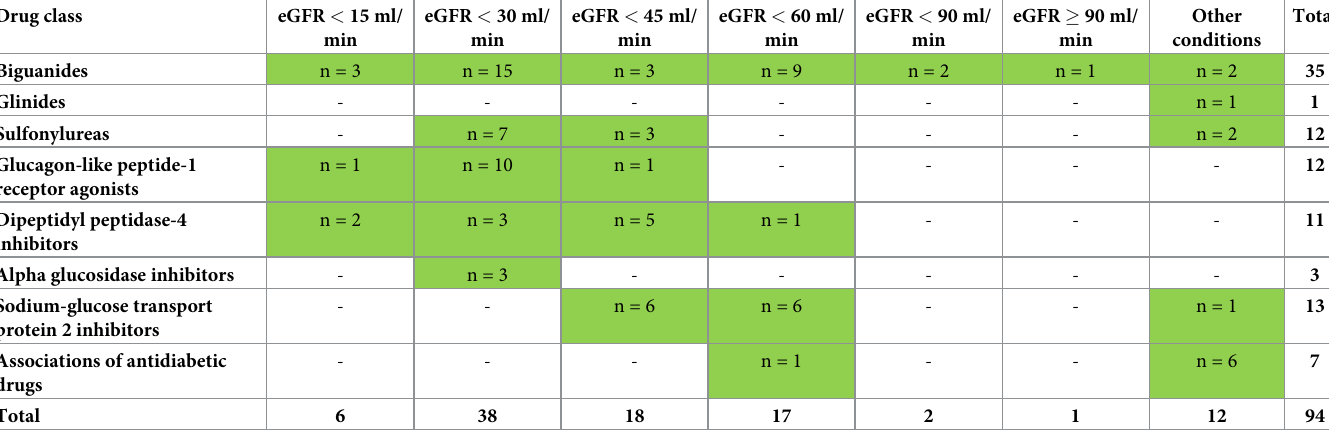
Table 2. Explicit definitions of PIPADs by renal failure stage, according to the KDIGO definition and classification system for acute kidney injury. Drug